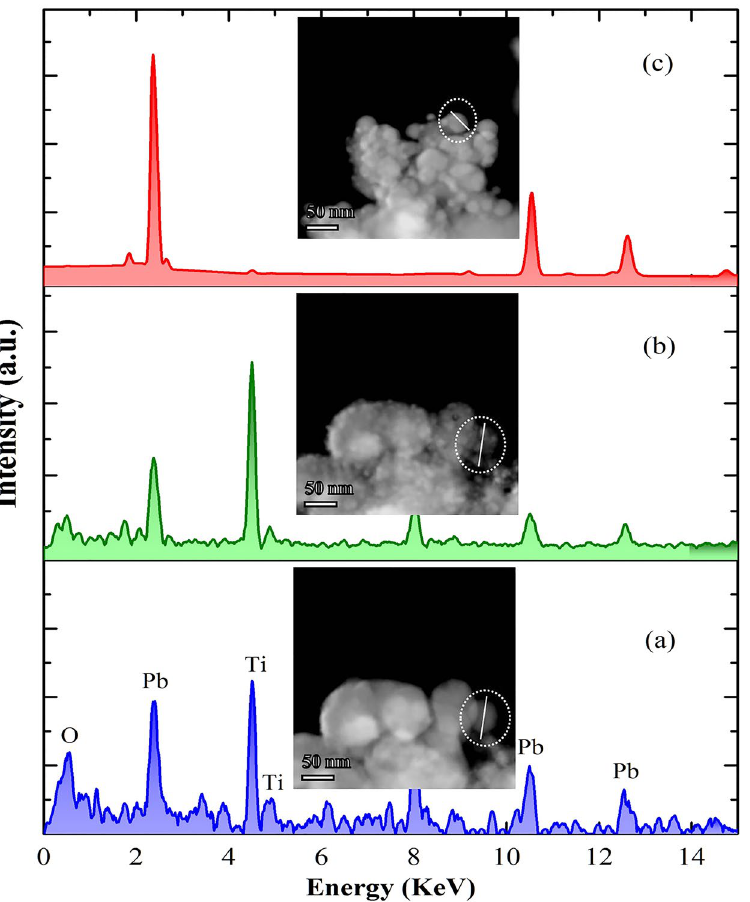
Figure 5. ( a , b and c ) are EDS spectrum acquired from the PbTiO 3 sample before, after 80 sec and prolonged point of irradiation, respectively. The insets are corresponding High angle annular dark field (HAADF) images of the sample, which are analyzed by EDS method. The circle denoted a line profile scanned